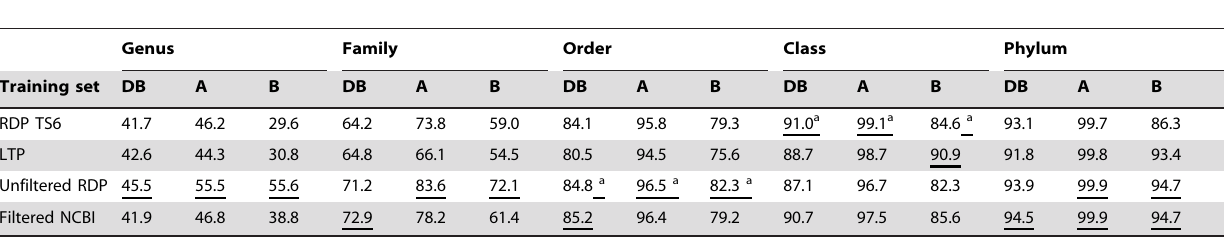
Table 2. Comparison of classification coverage of V4 reads from fecal samples among different training sets.